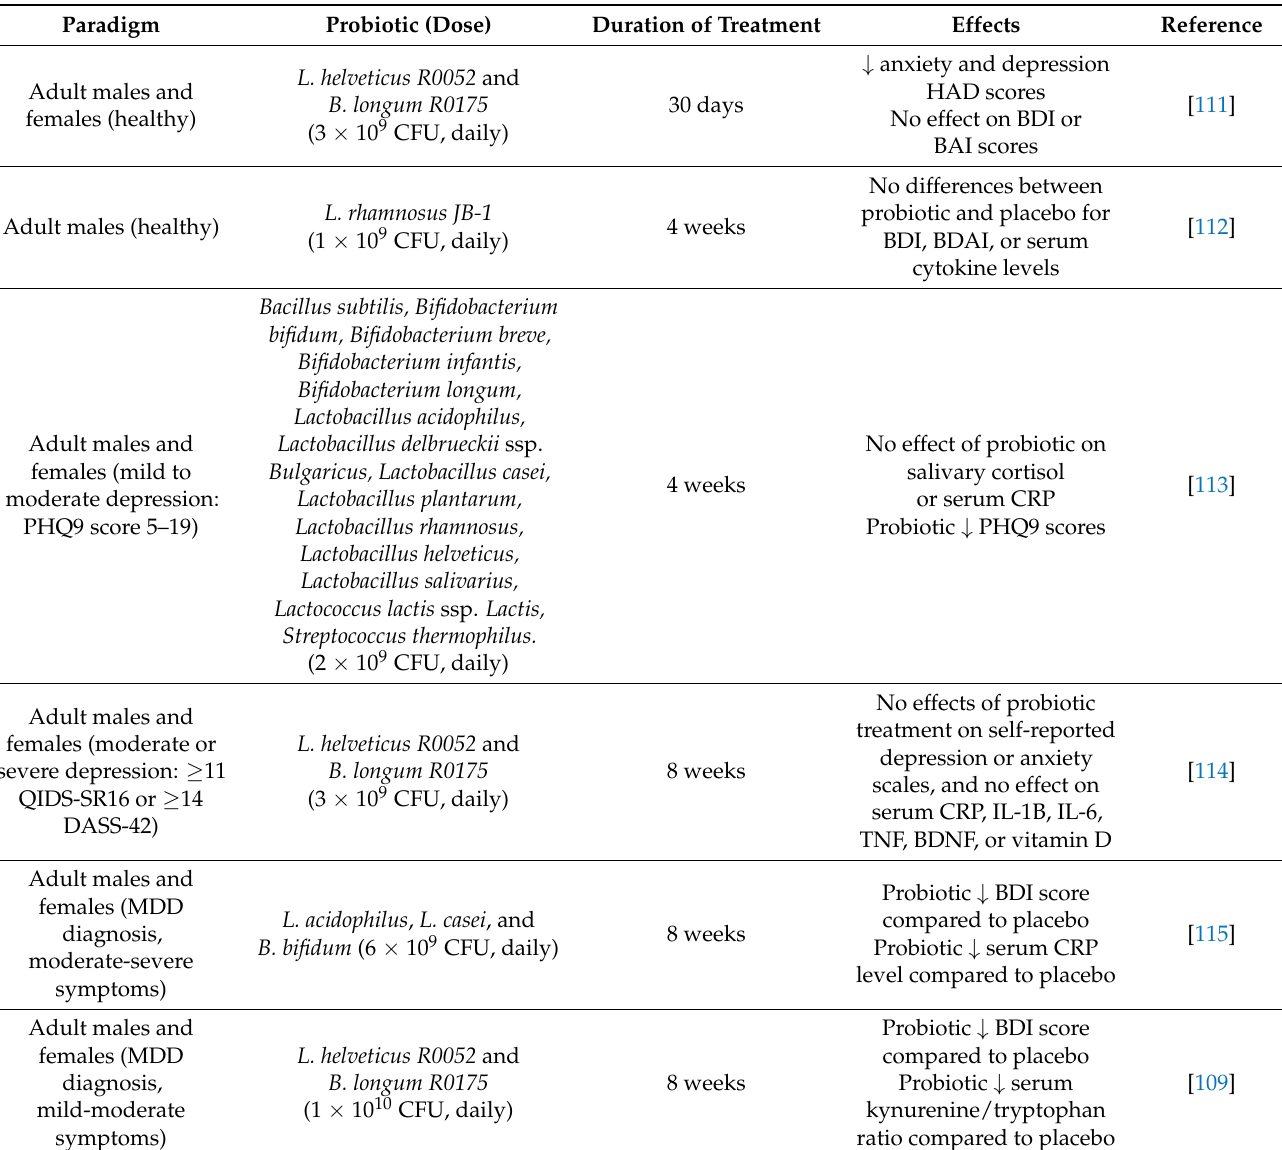
Table 2. Summary of probiotic studies on anxiety and/or depressive symptoms in humans. ↑ increase, ↓